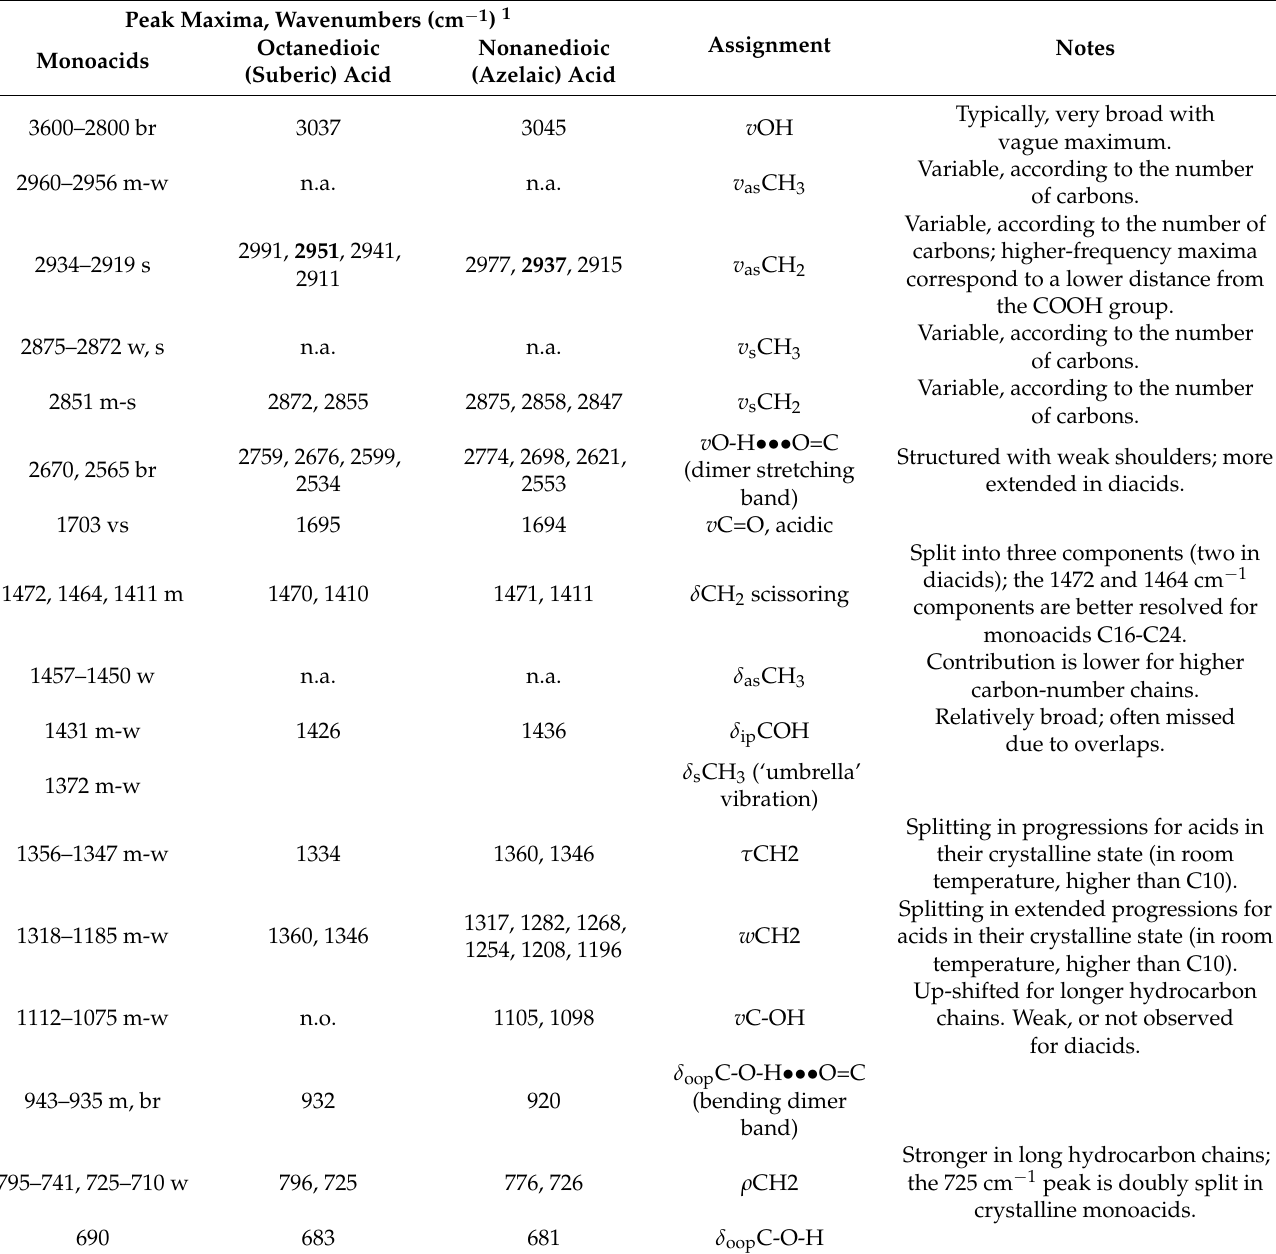
Table 1. Main infrared peaks and assignments of saturated fatty carboxylic monoacids and